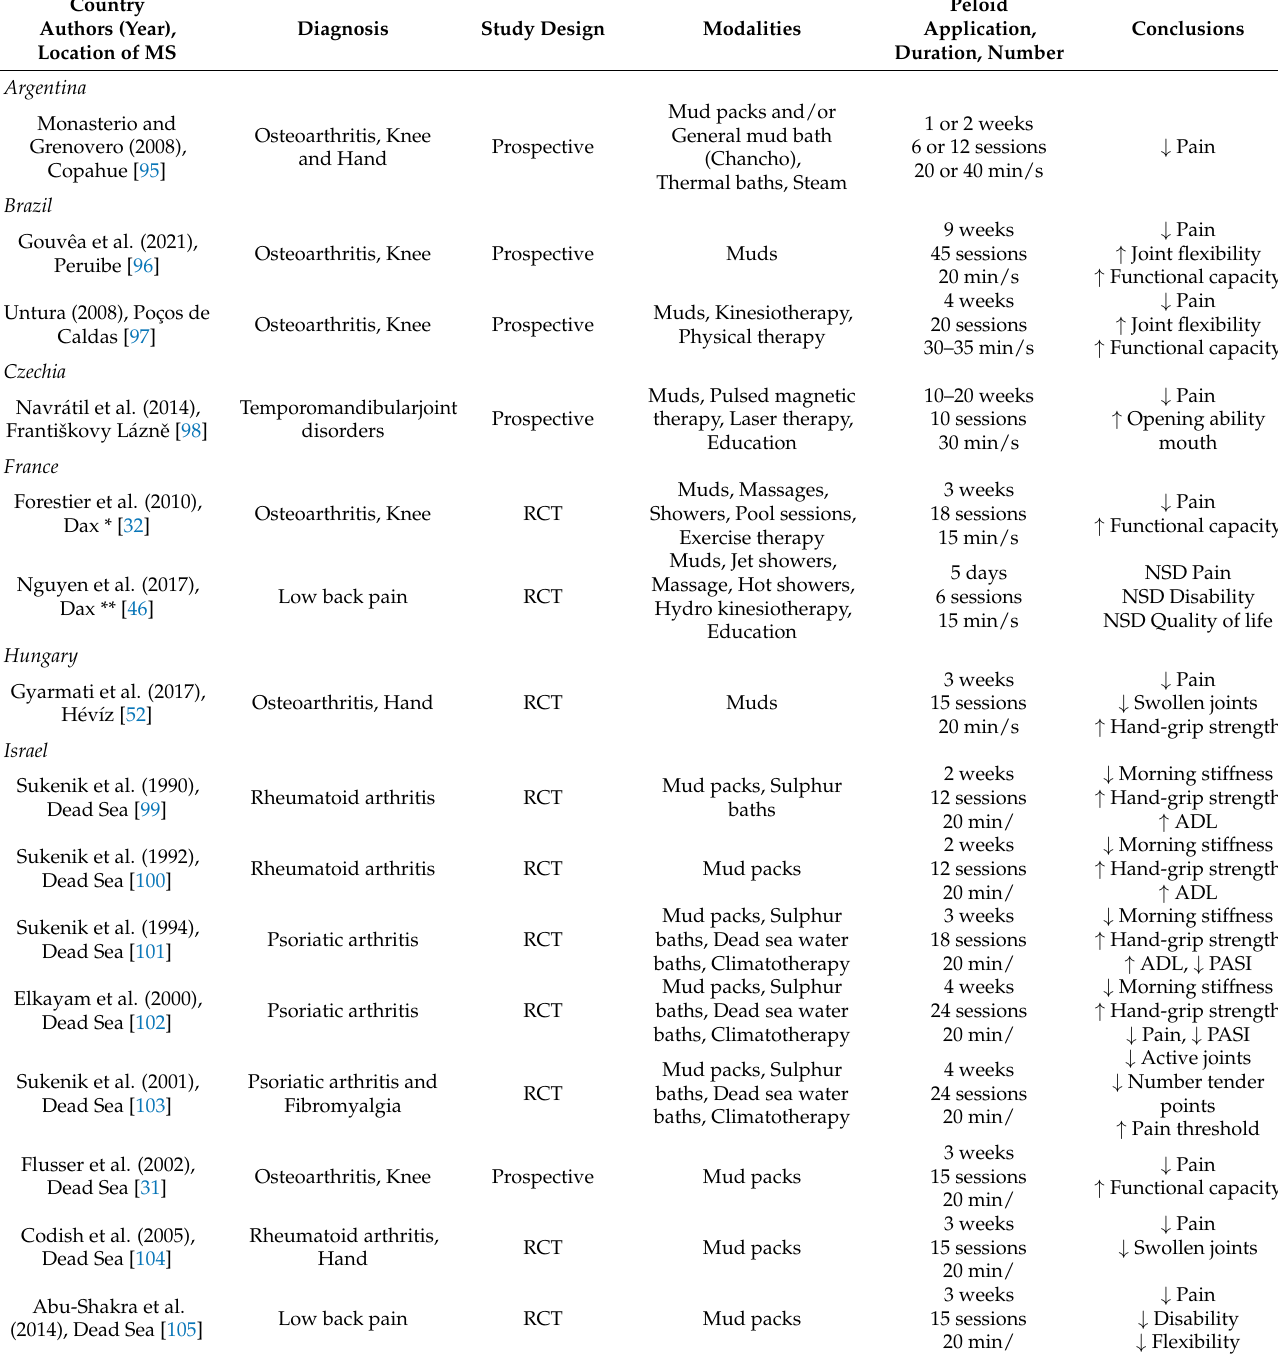
Table 1. Authors, diagnosis, study design, modalities, application and conclusions of peloids used in medical spas (MSs). Country Authors (Year), Location of